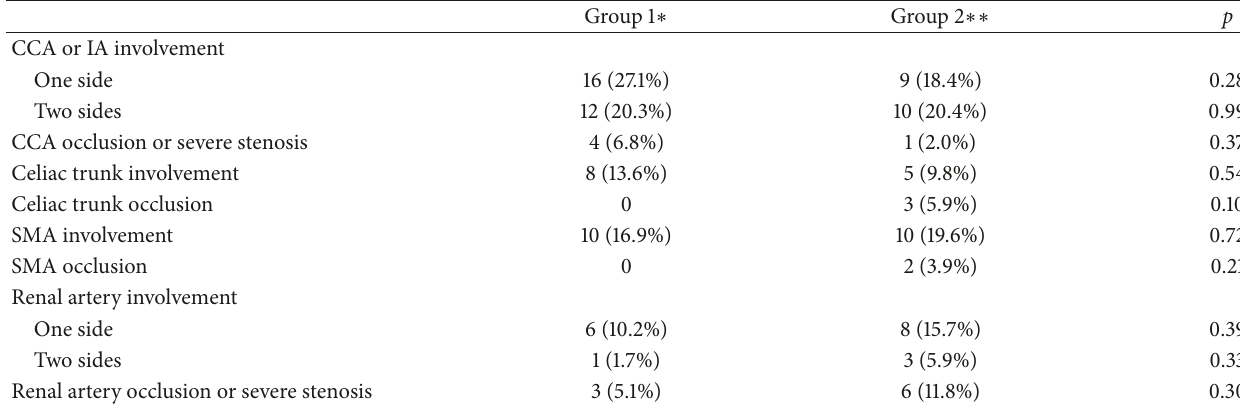
Table 2: Aortic vessel